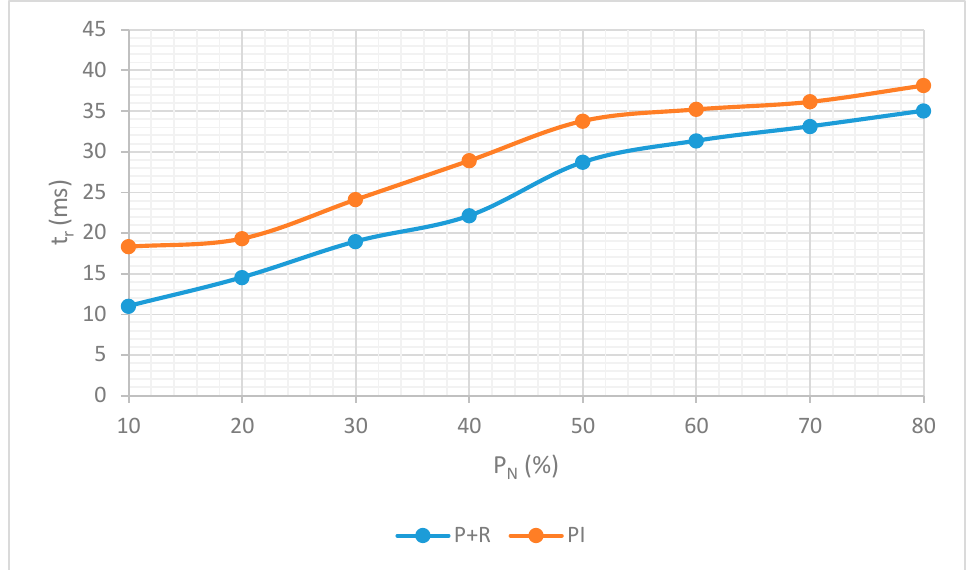
Figure 22. Comparison of adjustment times of P+R and PI controllers in the tested system for changes in the reactive component at a constant active component (0.5 P N ).